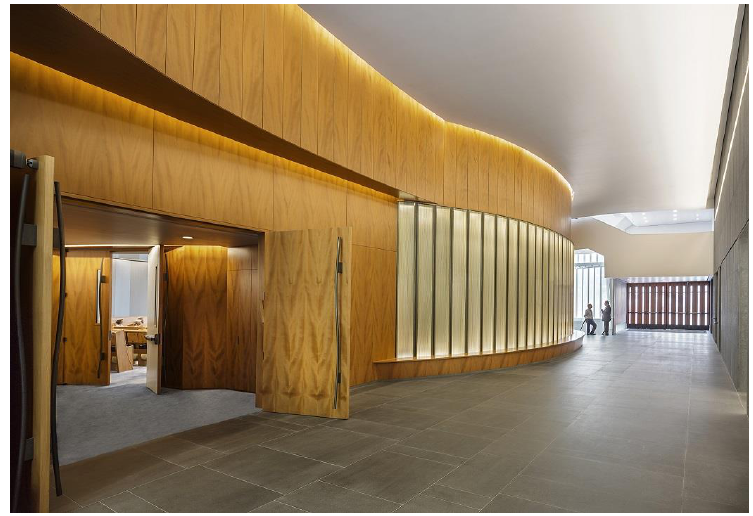
Figure 5. Lobby, cedar wall on north side of lobby, looking east. Photo David Sundberg/ESTO; on the left side is a view from the lobby recess into the sanctuary.